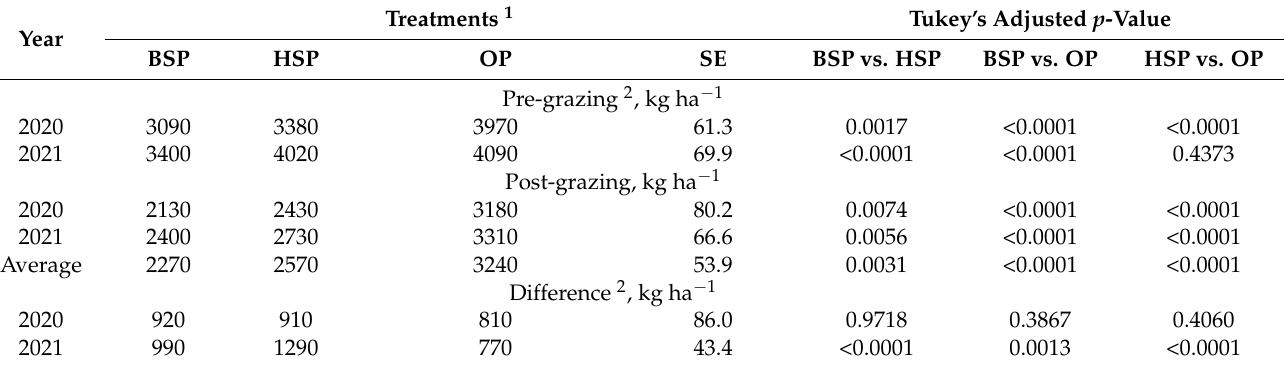
Table 3. Estimated pre- and post-grazing forage biomass and herbage disappearance (difference) in an open pasture (OP), black walnut silvopasture (BSP), and honeylocust silvopasture (HSP) treatments during the summers of 2020 and 2021 at the Whitethorne Agroforestry Demonstration Center, Blacksburg, VA, USA.